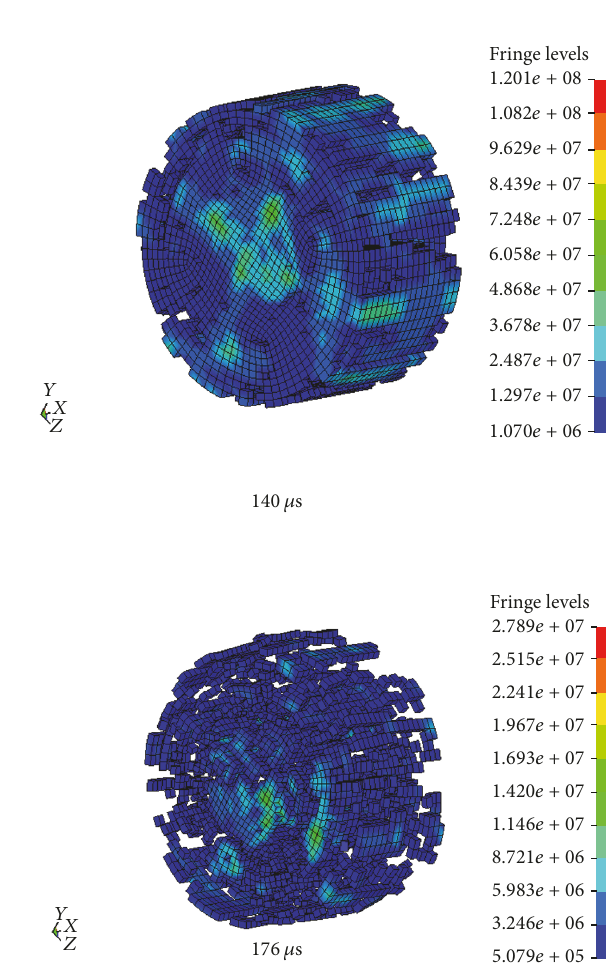
Figure 13: Numerical fracture process (the average strain rate is 130 s −1